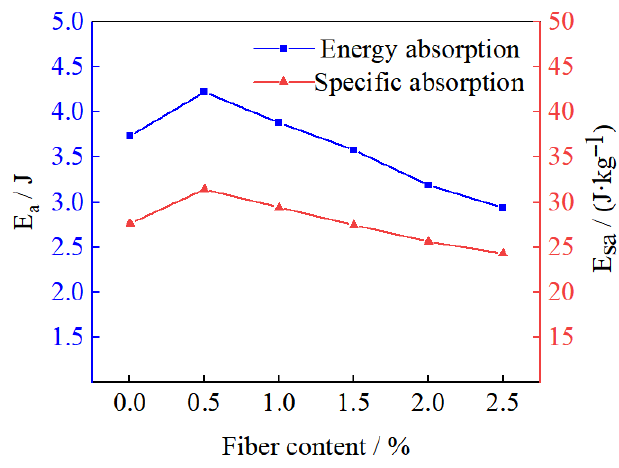
Figure 10. Effect of fiber content on energy absorption capacity of the concave hexagonal unit cell.